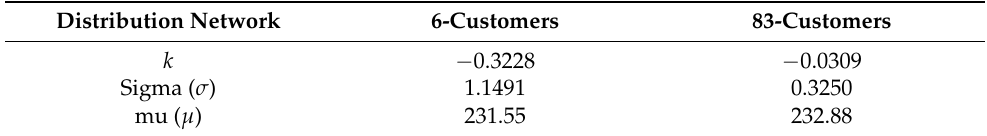
Table 1. The background voltage input parameter for the characterised GEV pdf for the 6-customers and 83-customers distribution networks was applied to estimate EV charge hosting